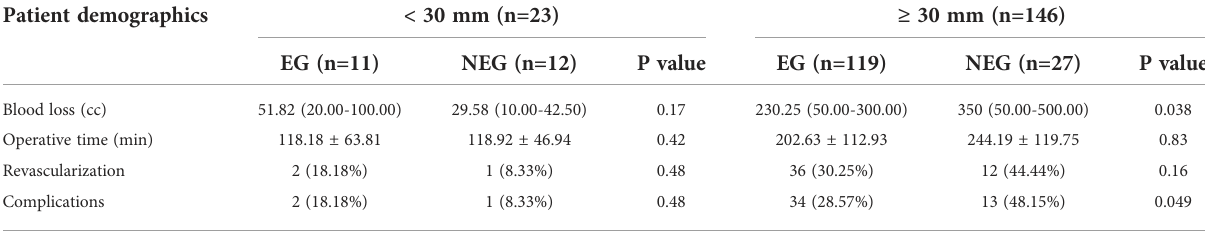
TABLE 4 Differences between the embolization group and non-embolization group according to tumor size.